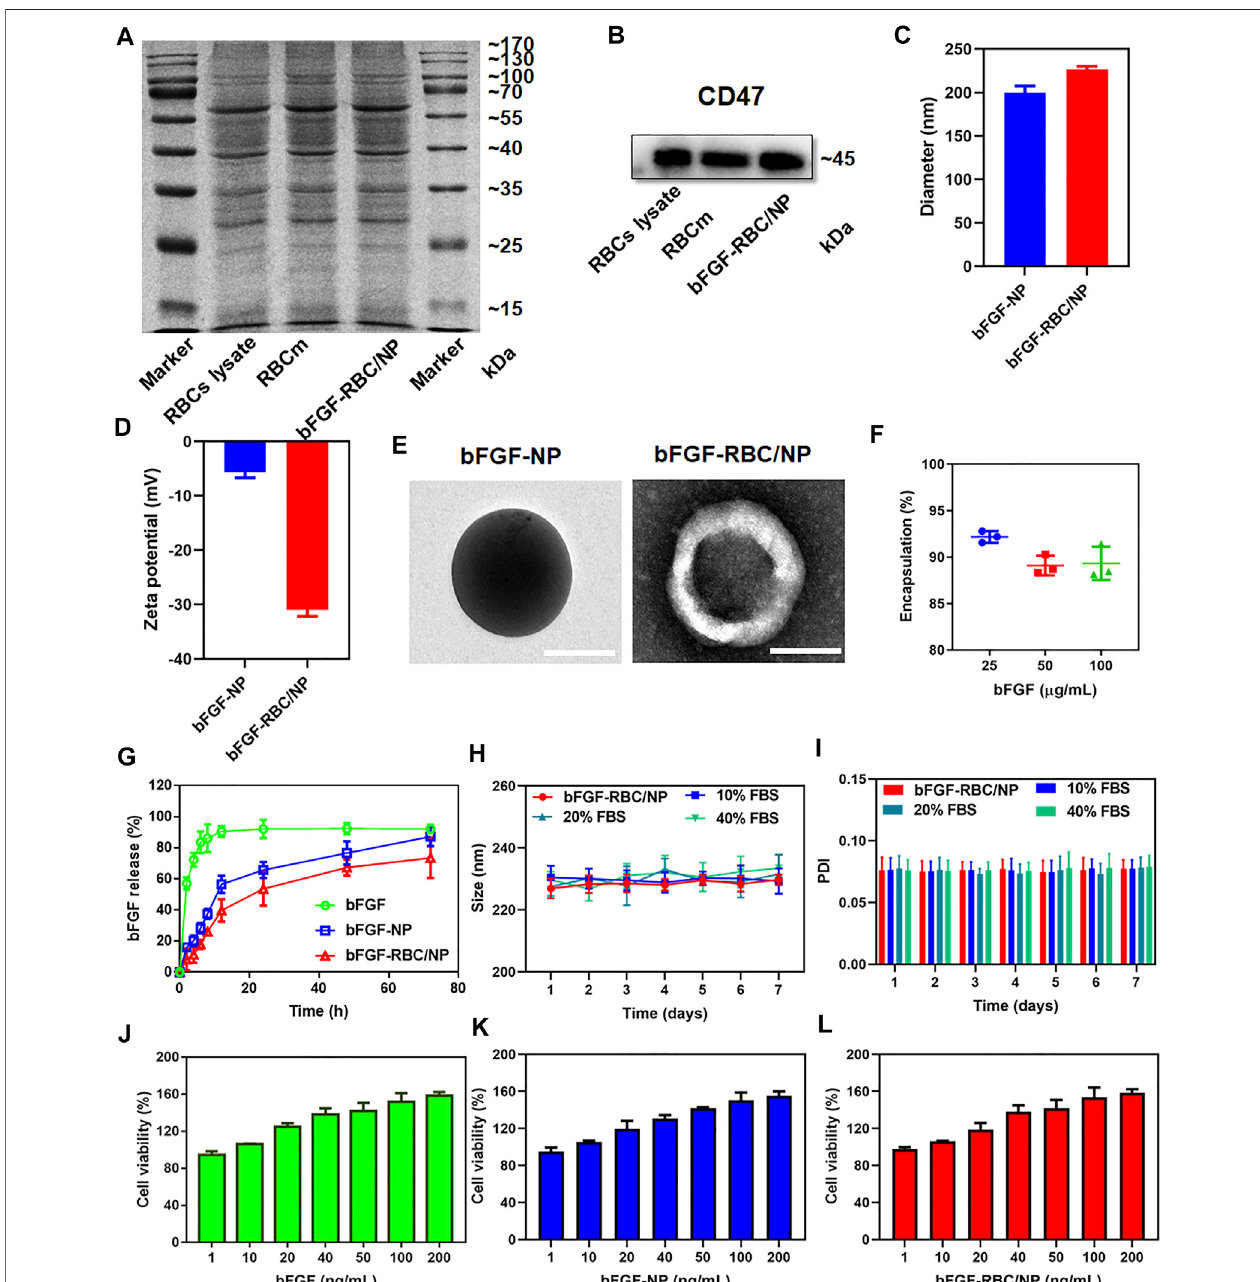
FIGURE 1 | Characterization of bFGF-RBC/NP. (A) SDS-PAGE of red blood cell (RBC) lysate, RBC membrane, and bFGF-RBC/NP. (B) Western blot analysis of CD47 in the RBC lysate, RBC membrane, and bFGF-RBC/NP. (C) Diameter, (D) zeta potential, and (E) TEM of bFGF-NP and bFGF-RBC/NP. (F) Encapsulation ef fi ciencyand (G) releaseofbFGF-RBC/NP. (H) Sizeand (I) PDIofbFGF-RBC/NPinPBScontaining0,10,20,and40%FBSfor7 days.Cellviabilityaftercellincubation with different concentrations of (J) bFGF, (K) bFGF-NP, and (L) bFGF-RBC/NP. Data are expressed as the mean ± SD ( n = 3). Scale bar = 100 nm.